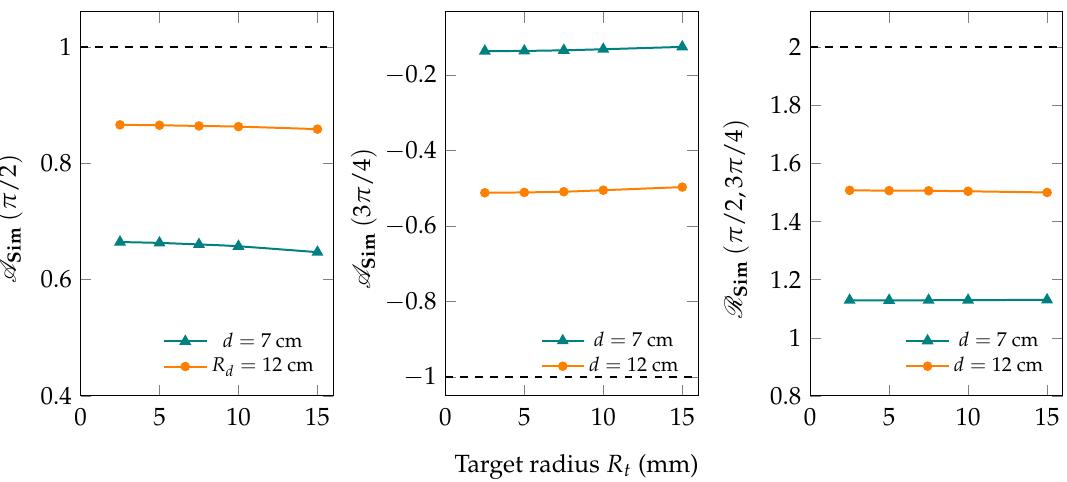
Figure 9. The same as Figure 6 for the quadrupole transition with a spin sequence of 0 → 2 →